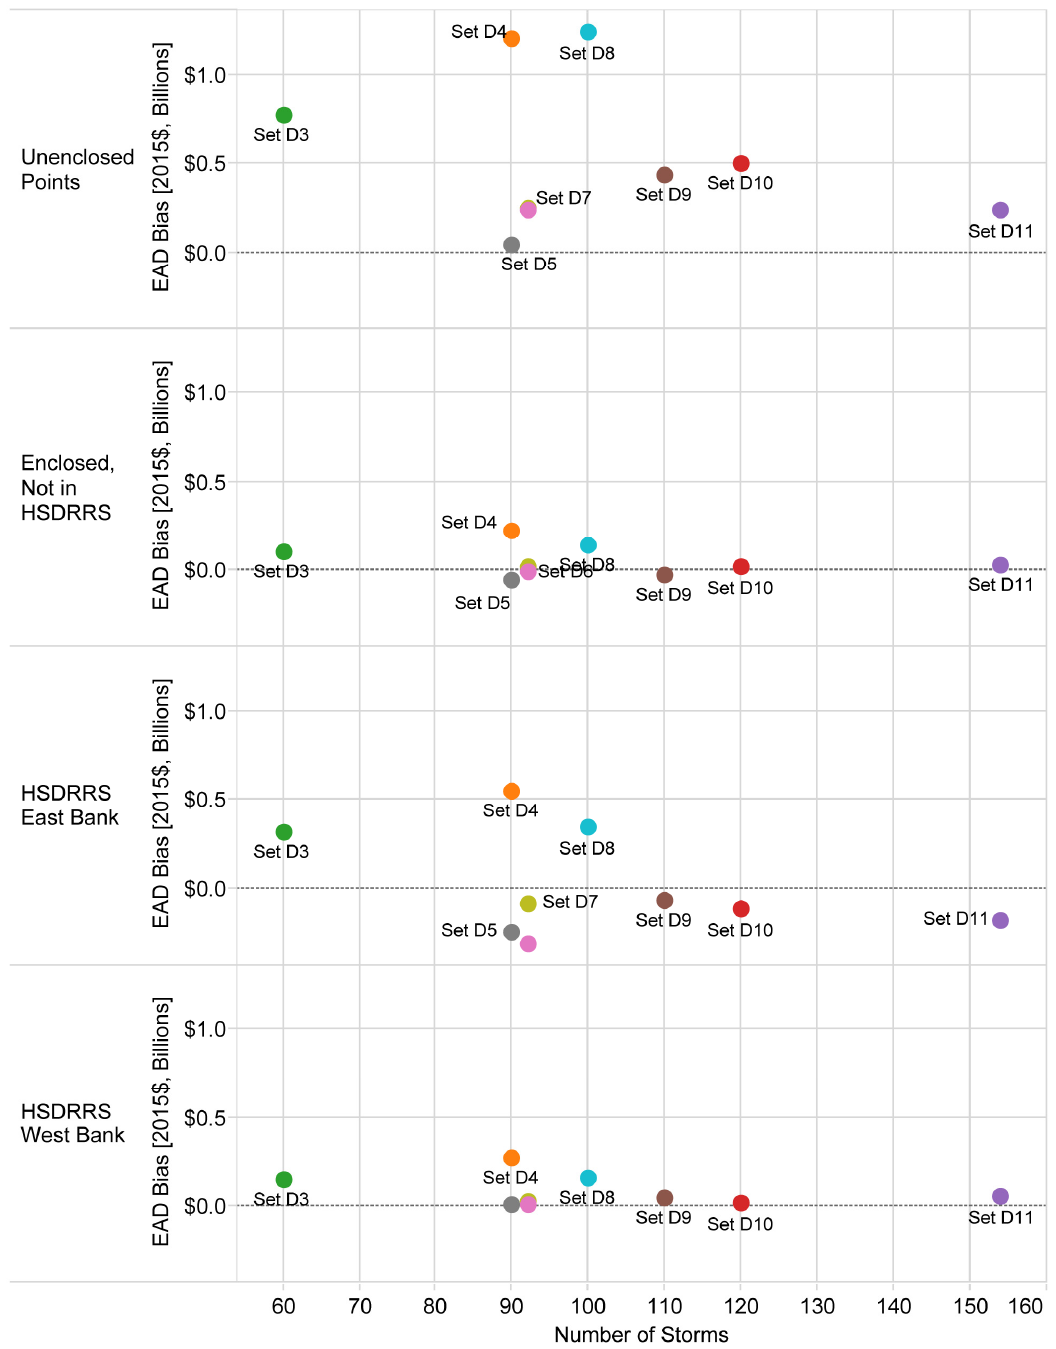
Figure 10. Bias in expected annual damage (median estimates), by location.